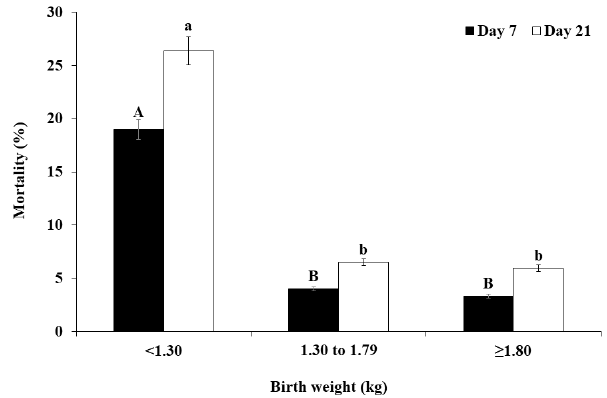
Figure 1. Percentage of mortality at days 7 and 21 for all piglets classified into low (<1.30 kg, n = 216), medium (1.30 to 1.79 kg, n = 323) and high (≥1.80 kg, n = 151) birth weight categories. A,B,a,b Values with different superscripts within the same day differ significantly (p<0.05).